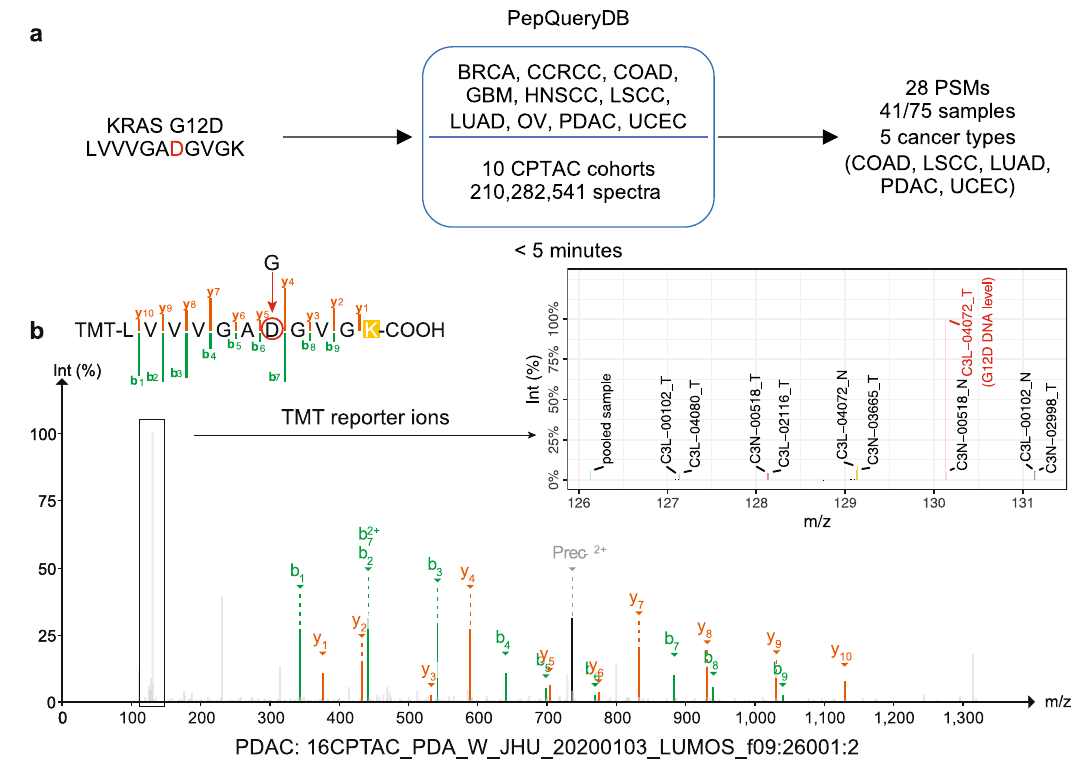
Fig. 2 | KRAS G12D variant peptide identi fi cation. a Identi fi cation of a novel peptide resulted from the KRAS G12D mutation in 10 CPTAC cohorts. b A repre- sentative MS/MS spectrum identifying the mutant peptide in a pancreatic cancer